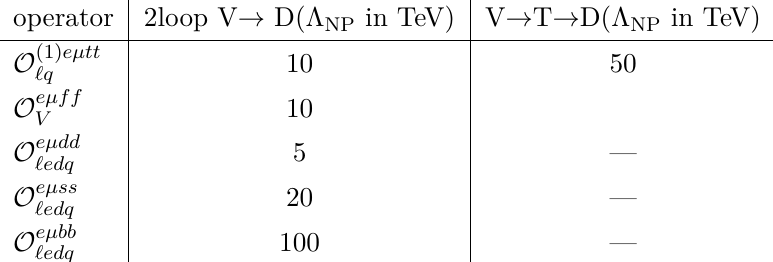
— — up to which coefficients . 1 could be NP V